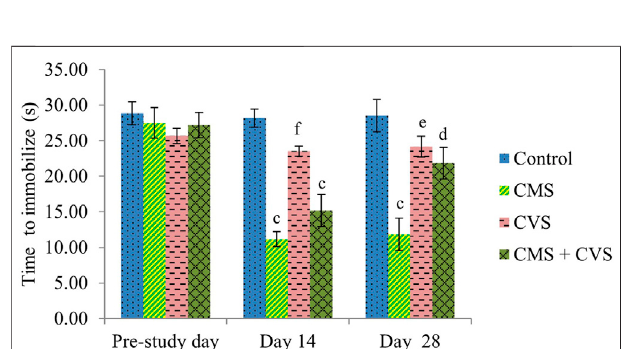
FIGURE1| EffectofCVSonlocomotoractivity.Valuesareexpressedas mean ± SEM ( n = 6). c p < 0.001 compared with that of control group; f p < 0.001 compared with that of CMS group. (One-way ANOVA followed by Tukey ’ s post hoc test).